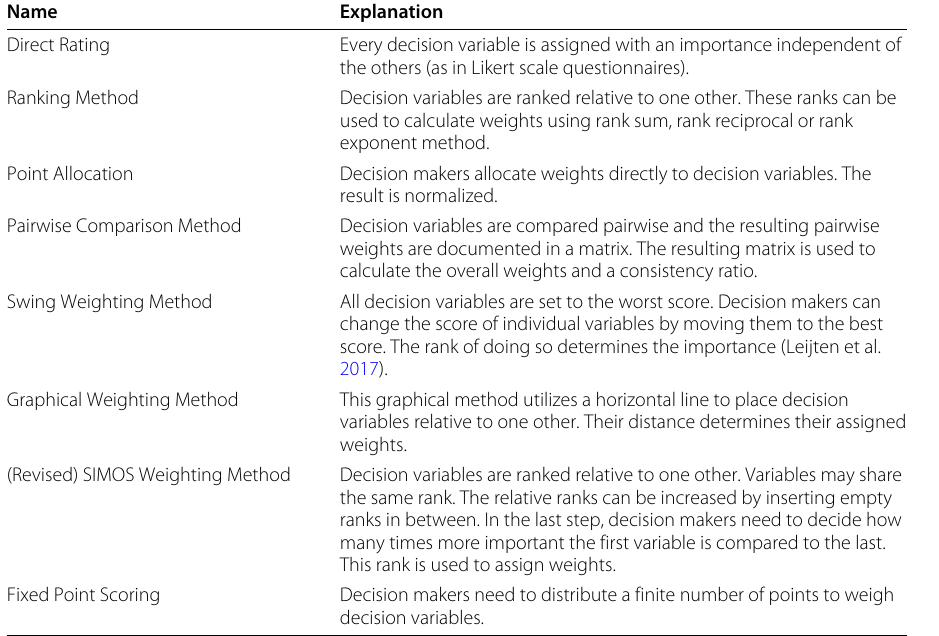
Table 4 Restrictions and limitations for